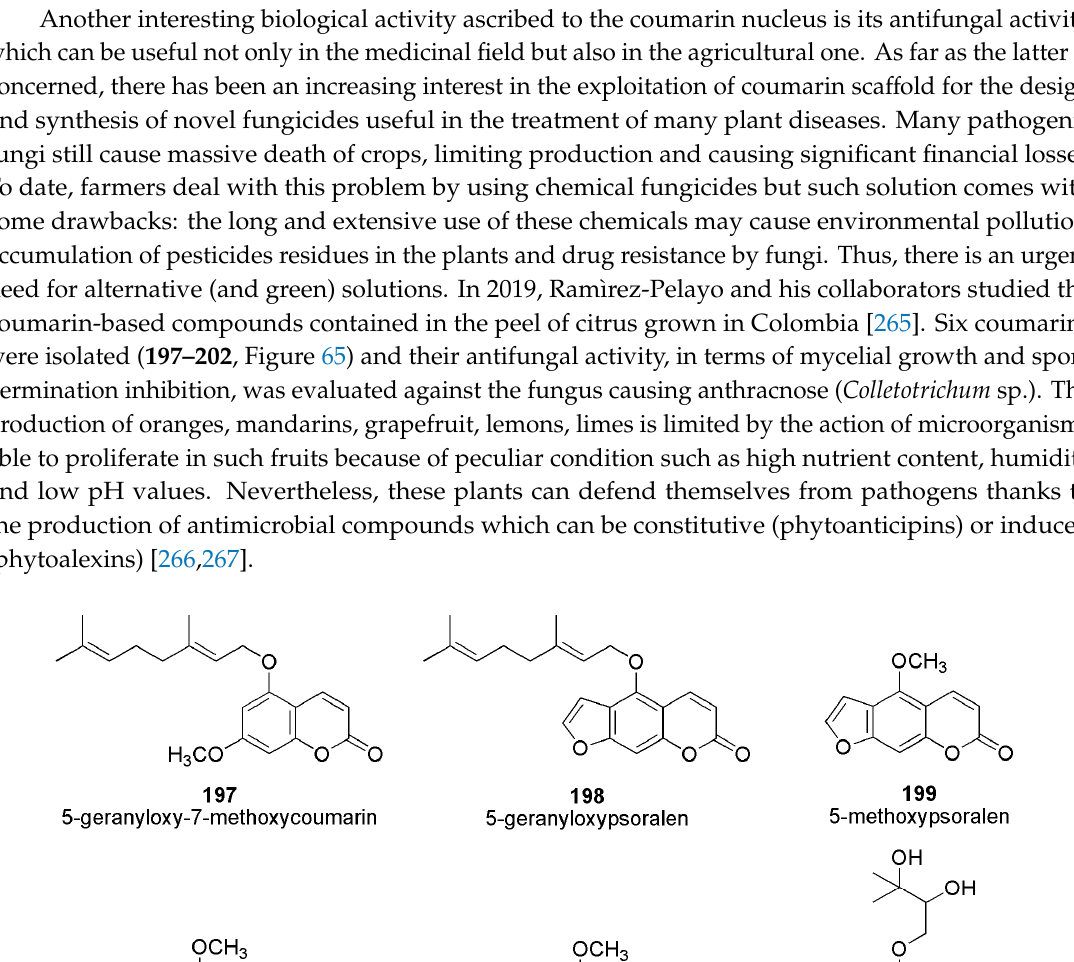
Figure 64. Chemical structure of coumarins umbelliferone, esculetin, daphnetin and xanthotol.